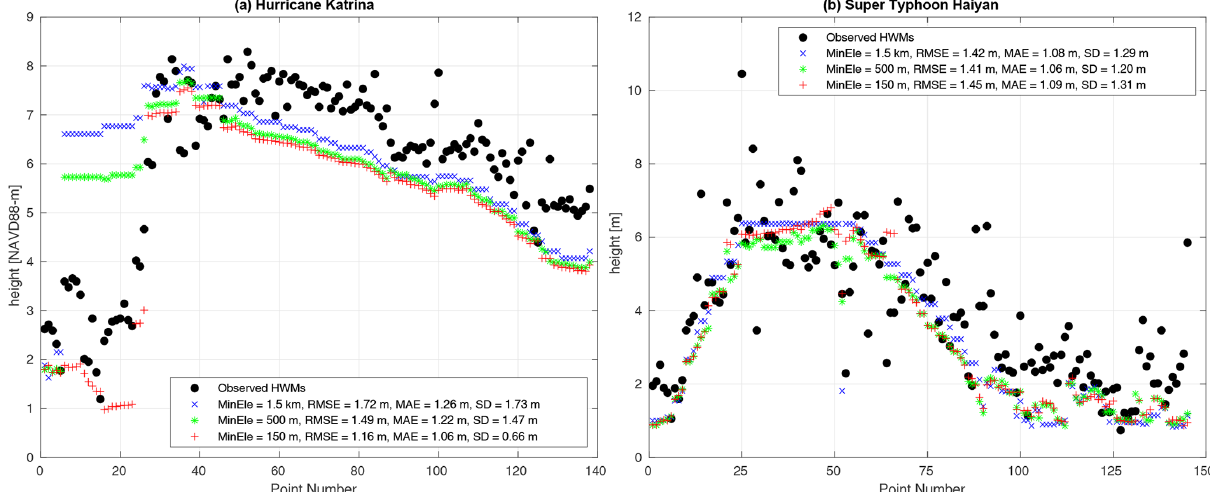
Figure 10. Comparisons of the observed HWMs to the simulated maximum storm tide height at the nearest vertex on meshes with different local MinEle (1.5km, 500m, 150m). (a) Hurricane Katrina (0.23m has been added to simulated results) and (b) Super Typhoon Haiyan. Points are numbered by starting from the most southwest point and following the shoreline clockwise